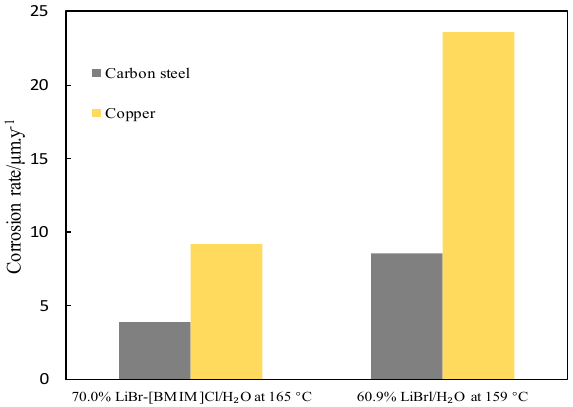
Figure 3. Corrosion rates of carbon steel and copper in LiBr–[BMIM]Cl / H 2 O and LiBr / H 2 O.